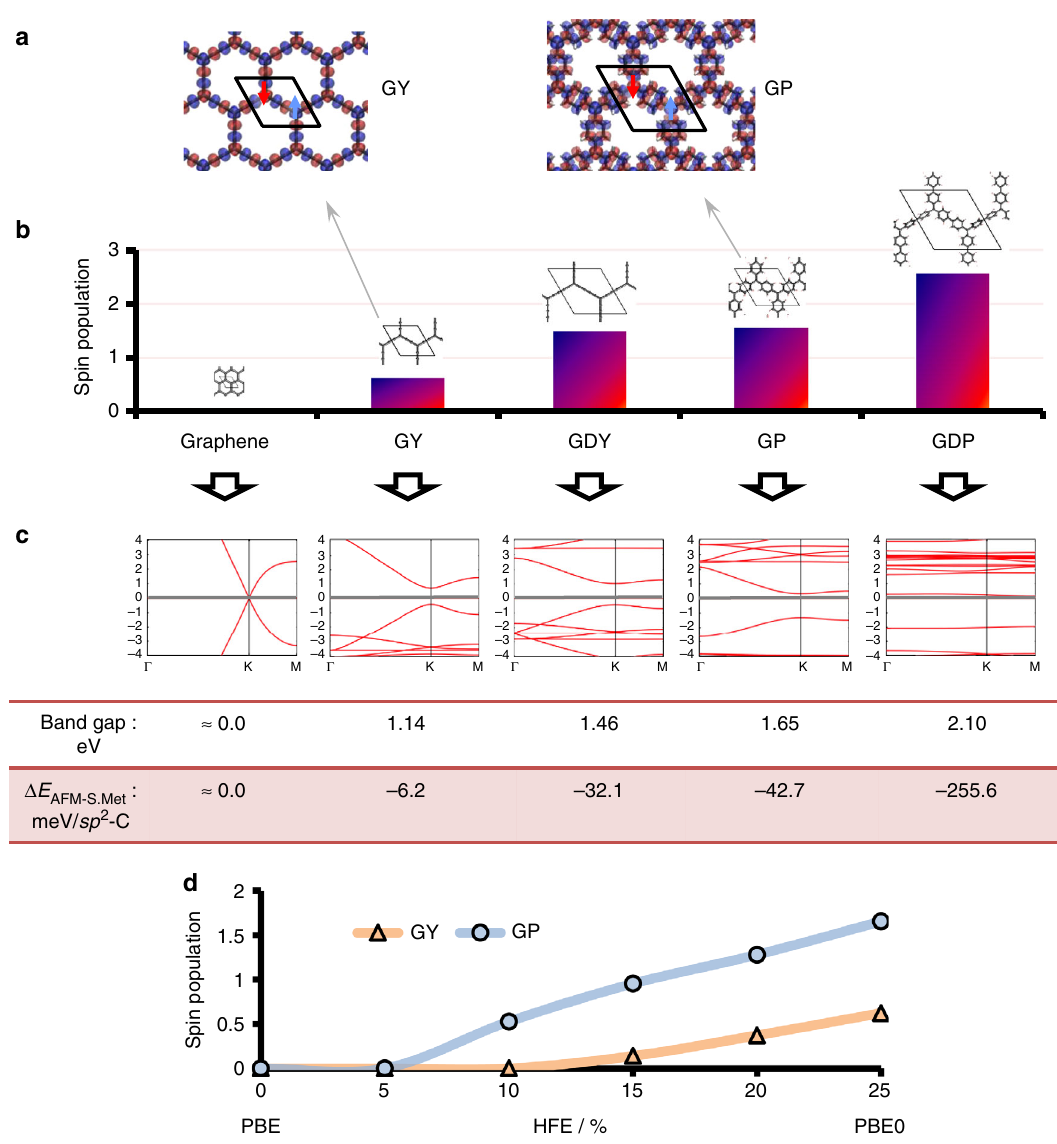
Fig. 3 Multi-radical AFM state. The results from spin-unrestricted open-shell PBE0 optimizations initialised using an AFM spin con fi guration. a Spin density iso-surface on GY and GP structures (alpha = blue; beta = red), where the unit cell is highlighted. b Total absolute spin population (i.e., addition of all atom- partitioned spin-up and spin-down electronic populations) within the unit cell throughout the materials series. c Electronic band structures for each case. Below each band structure, we indicate the value of band gaps (eV) opening at the K point and the relative energy of the AFM solution with respect to the corresponding semimetallic solution per sp 2 triply bonded centre or node of the hexagonal net (each unit cell presents two nodes of the hexagonal net), Δ E AFM-S.Met in meV. d Absolute spin population in number of electrons versus percentage of HFE used in the DFT calculations for GY (orange) and GP